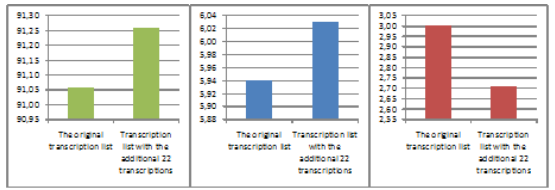
Figure 5. The comparison of the recognition accuracy when 22, 10, 4 and 2 iteratively selected transcriptions and 2 original LBT based transcriptions were used.